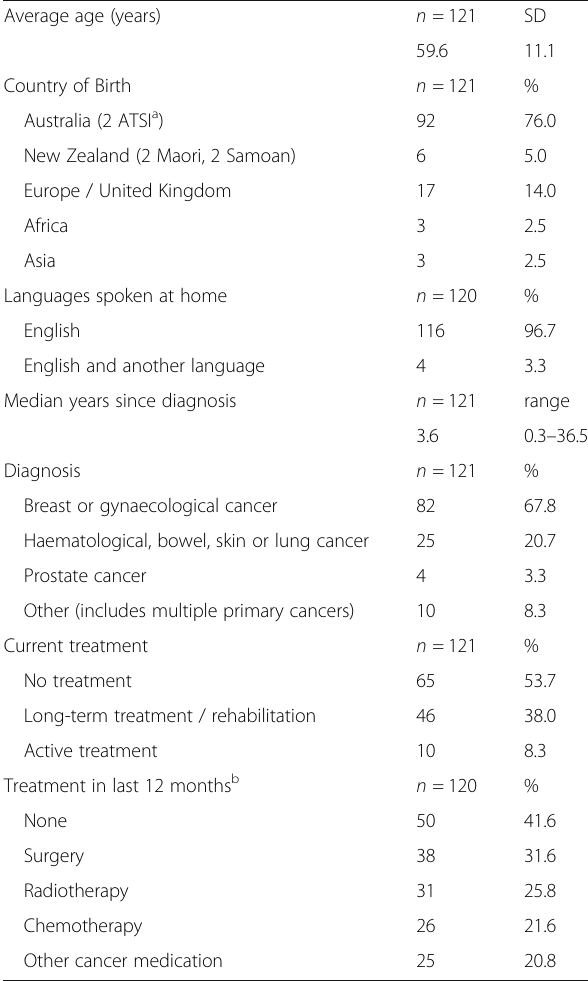
Table 2 Characteristics of survey